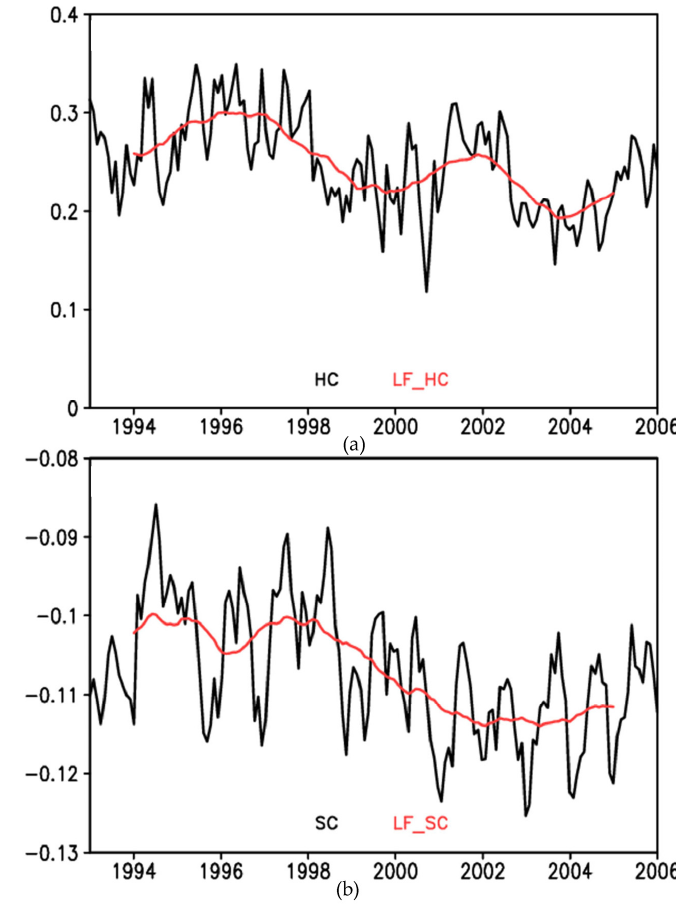
Figure 2. Time series of the low and high frequency components of the errors for ( a ) temperature, and ( b ) salinity, averaged over the upper 300 m in the model domain. The 24-month running mean is shown in red and the high-frequency error is shown in black.